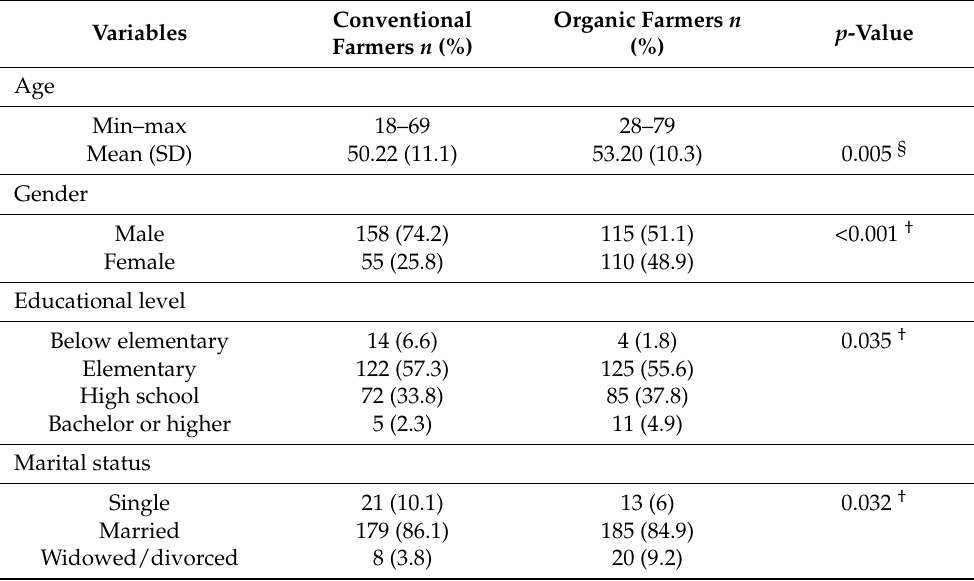
Table 1. Characteristic and risk factors of conventional farmers ( n = 213) and organic farmers ( n =